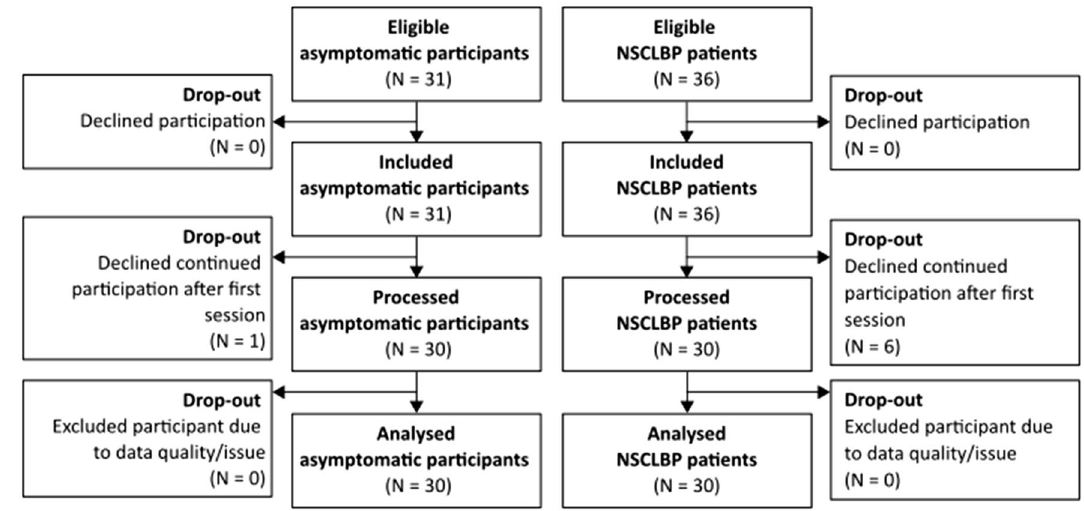
Figure 2. Participant flow diagram.